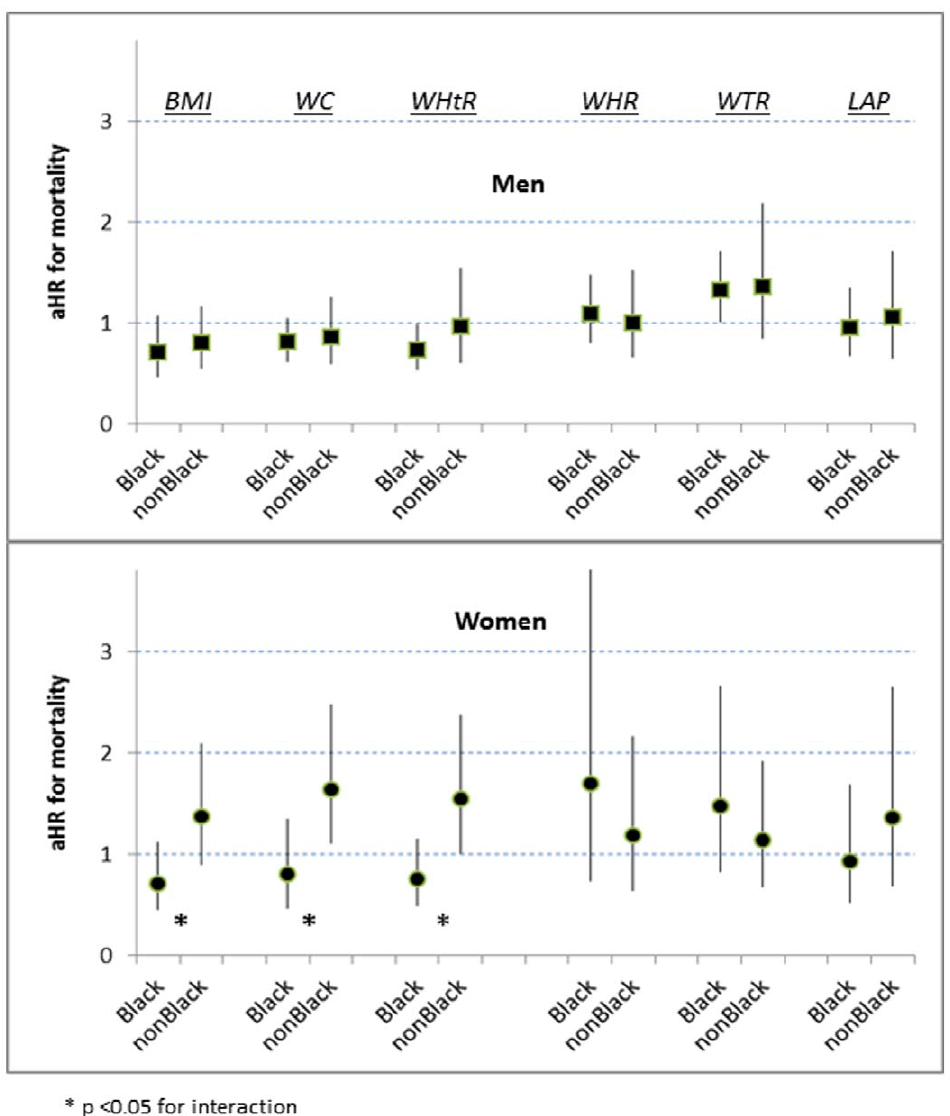
Figure 1. Interactions with ancestral group for mortality risk at p25, by 6 adiposity indicators. (aHR=multiply adjusted hazard ratio).